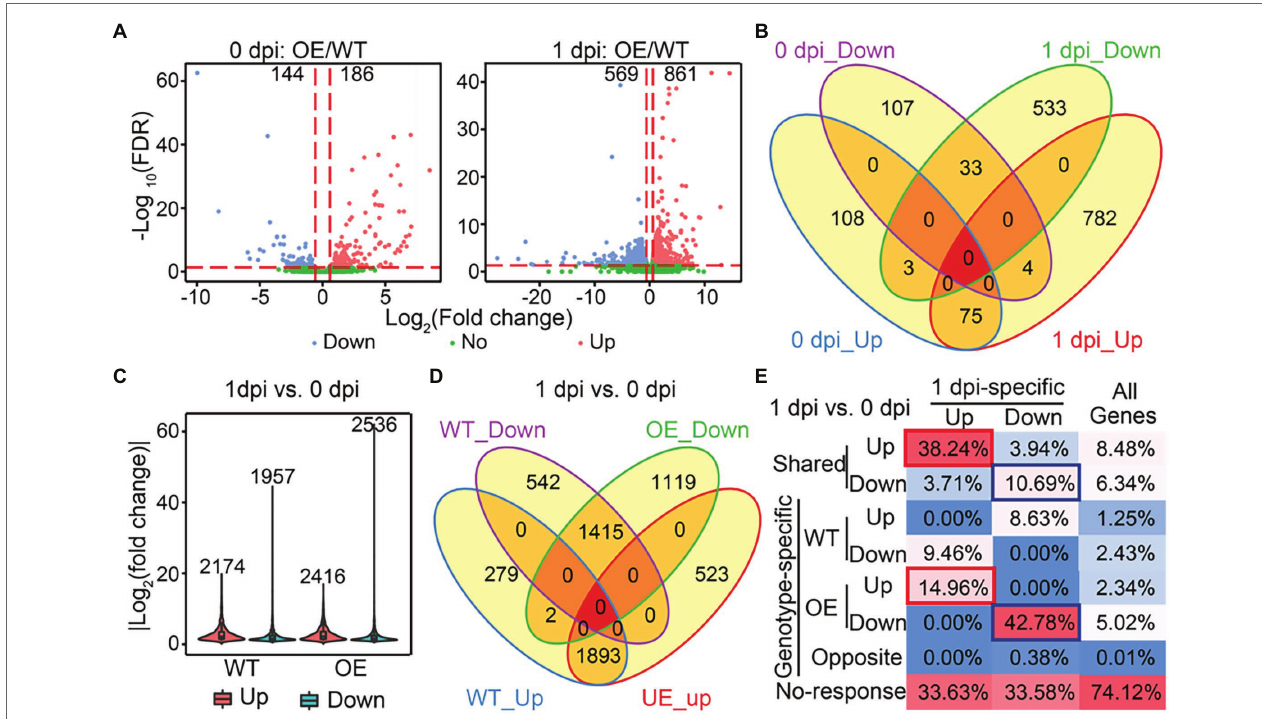
FIGURE 6 | Identification of SlLecRK1-regulated genes during resistance to FORL inoculation. (A) Volcano plots of the transcriptional changes were generated using edgeR. The log2 of the fold change is shown on the horizontal axis, and the -log10 of the adjusted value of p (FDR) is shown on the vertical axis. Red and blue dots represent significantly upregulated and downregulated genes, respectively. Green dots are genes with a non-significant change. The vertical and horizontal red dashed lines indicate the cutoff of the log2-transformed fold change and -log10 of the FDR. Numbers indicate the counts for genes showing upregulation and downregulation. (B) A Venn diagram showing the numbers of upregulated and downregulated genes between OE-1 and WT plants at 0 and 1 dpi. (C) The numbers and fold change distributions of DEGs regulated by FORL inoculation in WT and OE-1 plants. (D) A Venn diagram showing the comparison of DEGs induced by FORL inoculation between WT and OE-1 plants. (E) The categories and percentages of 1dpi-specific upregulated and downregulated genes according to the DEGs caused by FORL inoculation in WT and OE-1 plants. Red and blue boxes indicate type I and type II target genes, respectively. “All genes” indicates genes that were subjected to differential expression